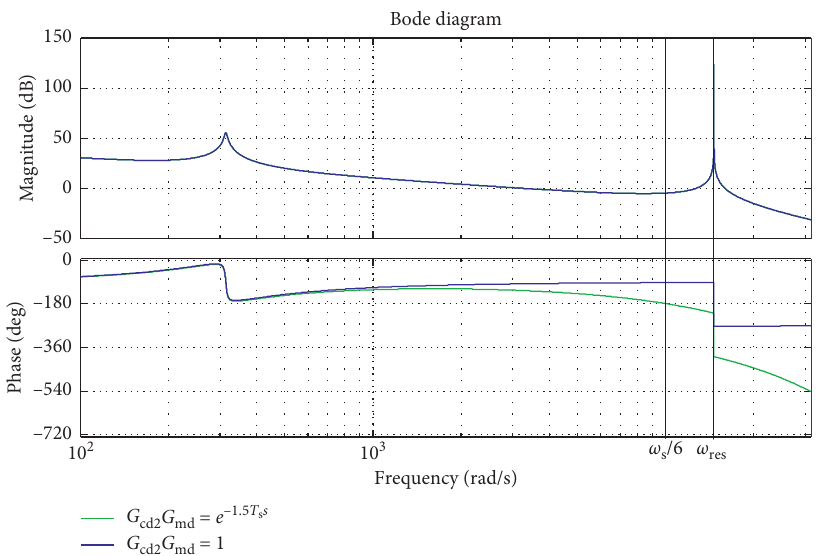
Figure 5: Bode plot of G